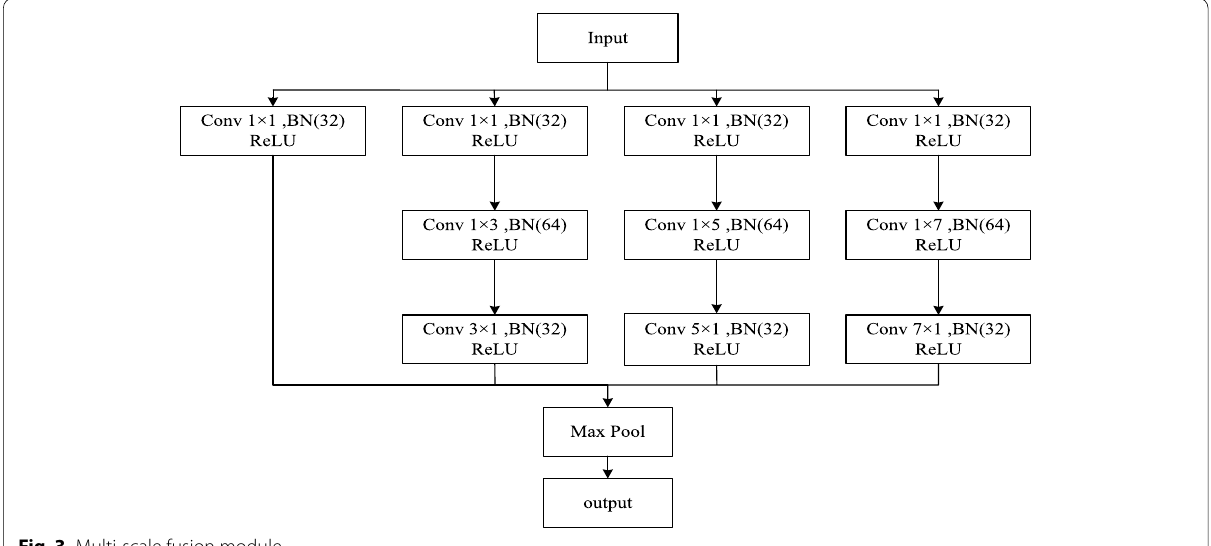
Fig. 3 Multi-scale fusion